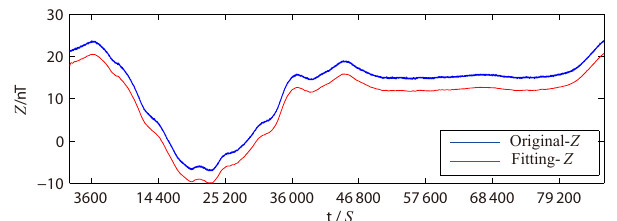
Figure 5. Autocorrelation function of background noise in the Z component on 29 May 2013 at